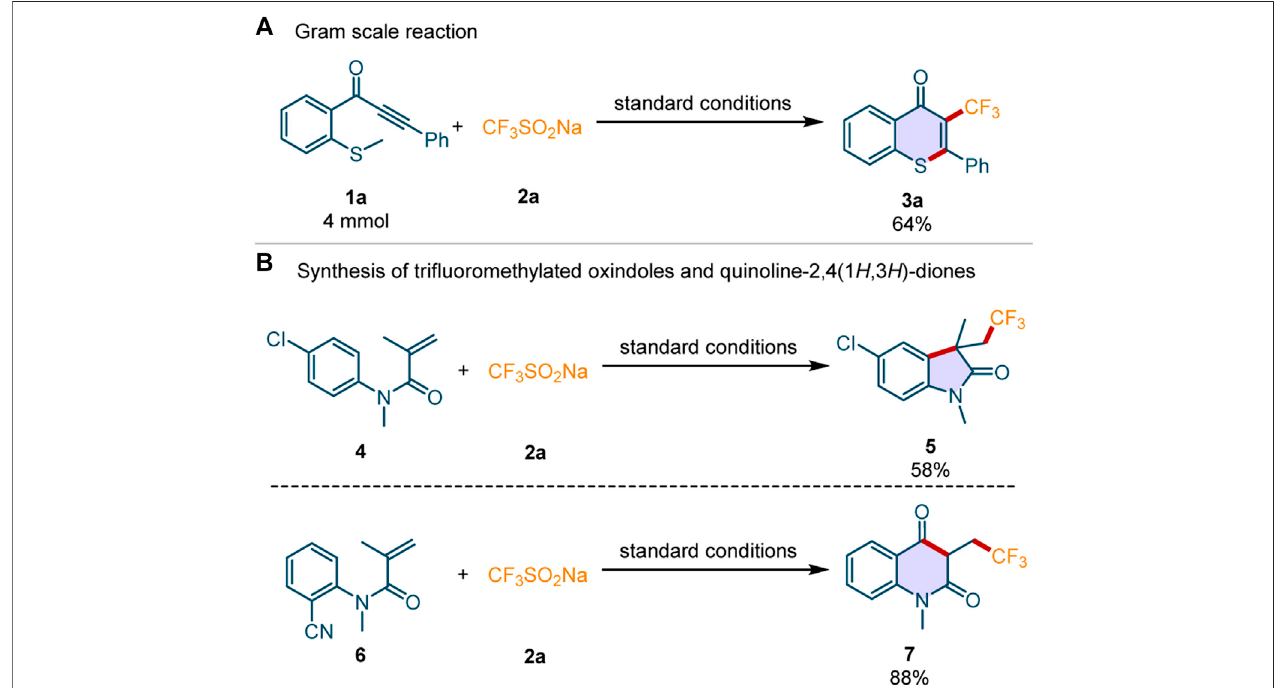
Scheme 4 | The gram-scale synthesis and the application of this per fl uoroalkylation/cyclization reactions.